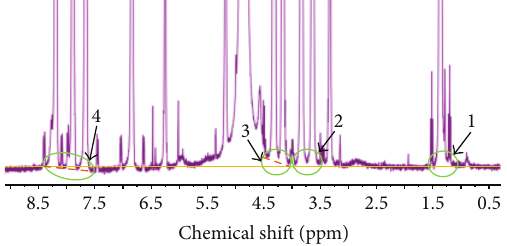
Figure 2: Baseline enlarged H-NMR spectrum of sample solution (chloramphenicol, ethyl paraben, and methanol-D 4 ).